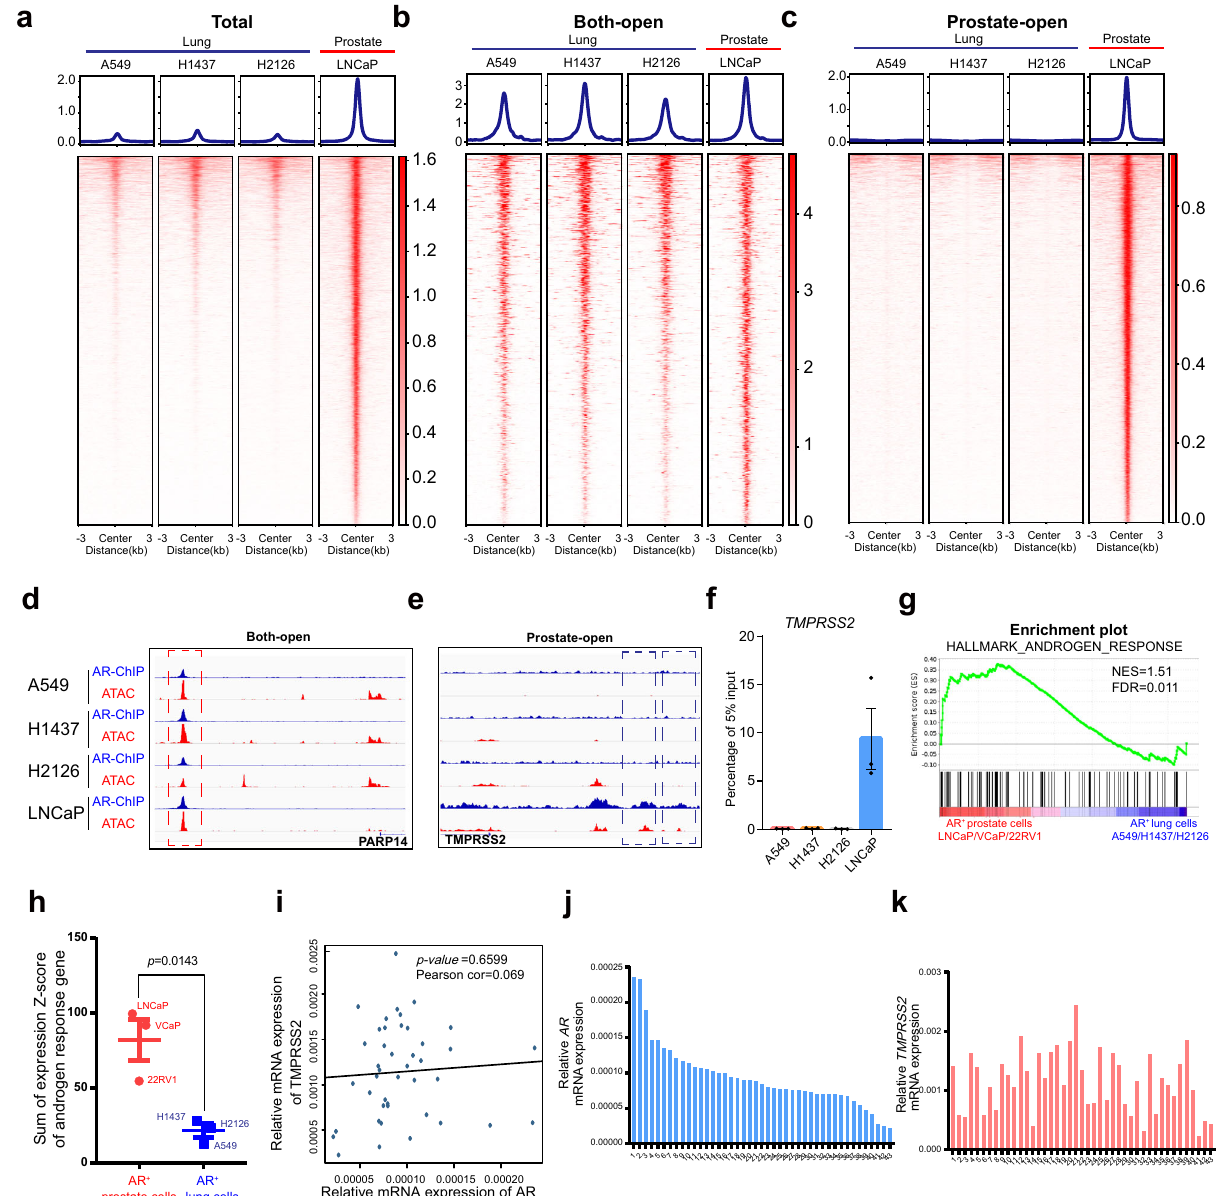
Fig. 5 Distinct AR binding pattern is characterized between human prostate cells and lung cells. a – c Pro fi le plot (top) and heatmap (bottom) of ATAC- seq data in a window around the peak center of LNCaP-generated total AR-binding sites ( a ), both-open sites ( b ) and prostate-open sites ( c ) in A549, H1437, H2126, and LNCaP cells, respectively. d IGV snapshot representing a both-open peak in PARP14 locus. e IGV snapshot representing a prostate-open peak in TMPRSS2 locus. f ChIP-qPCR analysis of AR binding activity in TMPRSS2 locus in A549, H1437, H2126, and LNCaP cells, respectively (mean ± SEM, n = 3 biologically independent samples). g GSEA enrichment plot of AR-positive prostate cells versus AR-positive lung cells using hallmark androgen response genes. h Sum of mRNA expression Z-scores of hallmark androgen response genes in AR-positive prostate cells and AR-positive lung cells (two- tailed t -test, mean ± SEM, n = 3 biologically independent cell lines). i Correlation analysis for relative mRNA expression of AR and TMPRSS2 in freshly dissociated human lung cells from 43 normal lung tissue samples using qRT-PCR (Pearson correlation test). j , k Relative mRNA expression of AR ( j ) and TMPRSS2 ( k ) in freshly dissociated lung cells from 43 normal lung